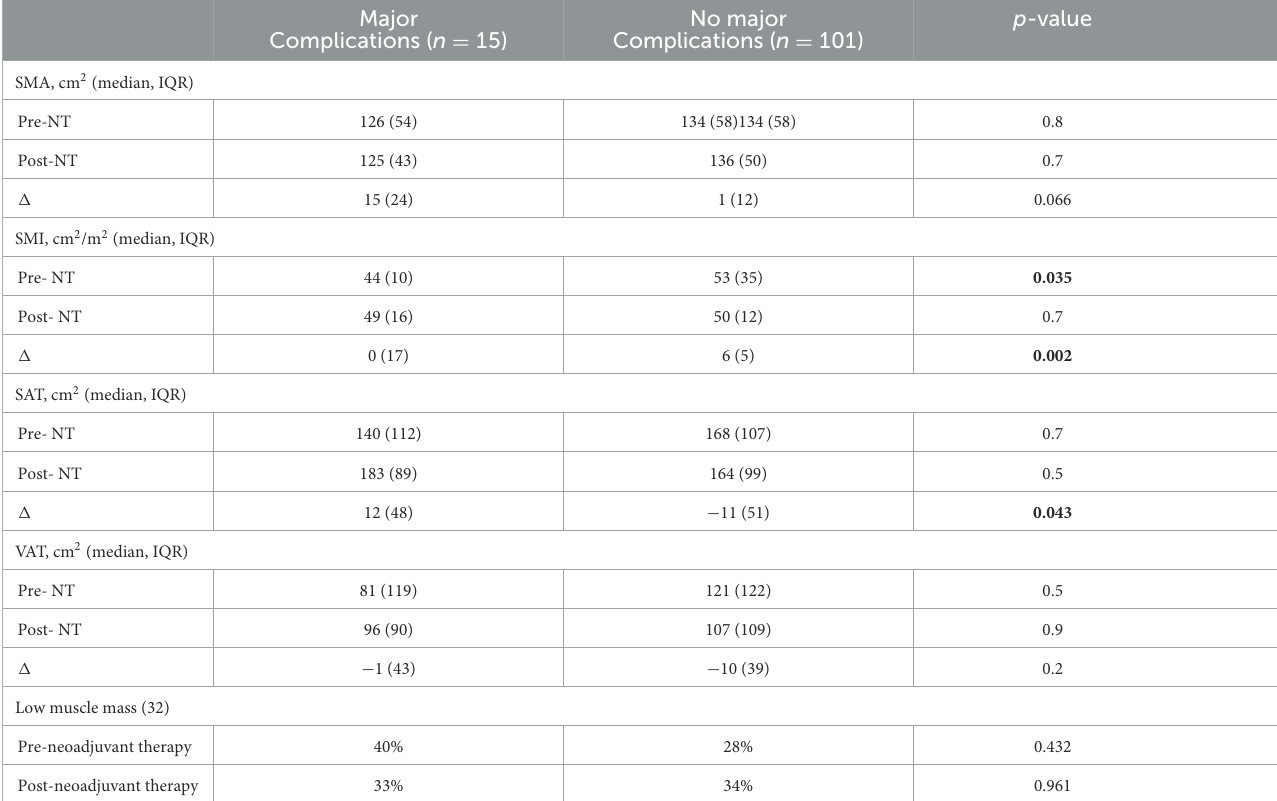
TABLE 3 Body composition changes and major postoperative